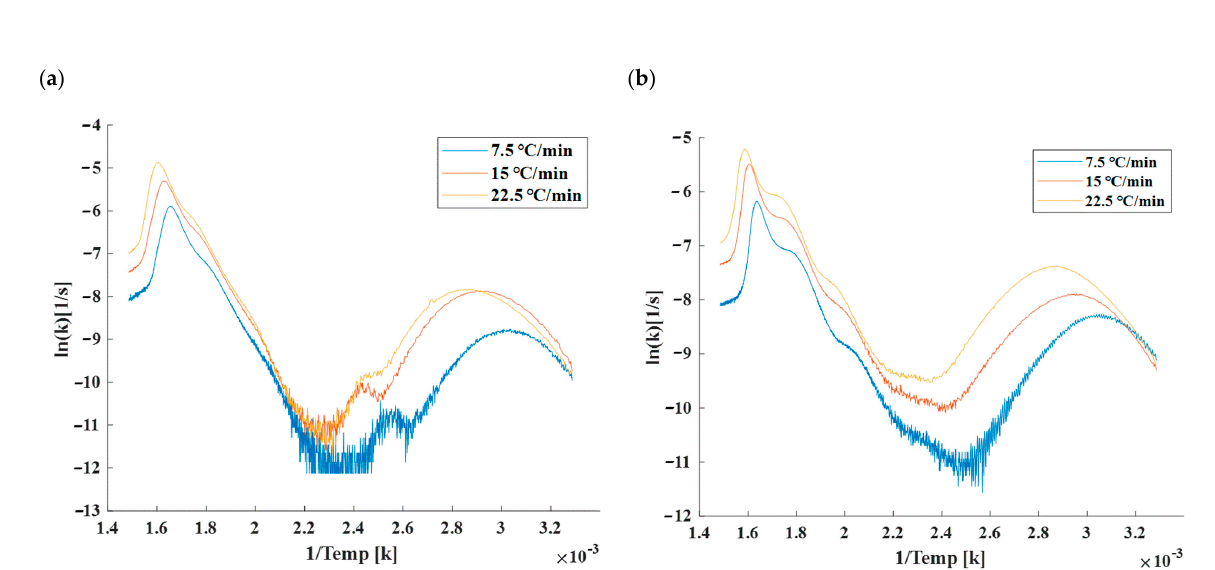
Figure 8. Biomass reduction curves for grape branch ( a ) and perilla ( b ) at various heating rates.